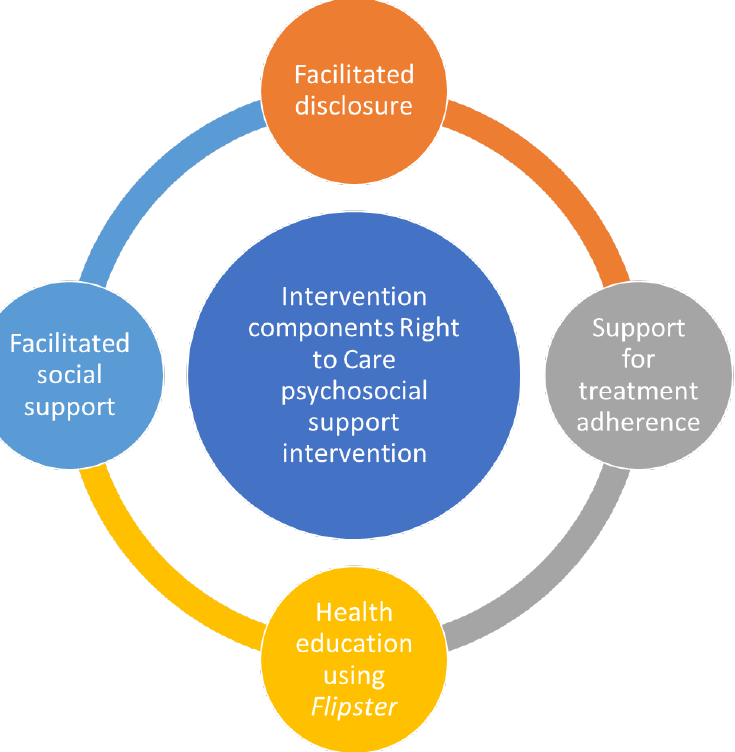
Figure 1. Intervention components of the Right to Care psychosocial support intervention.